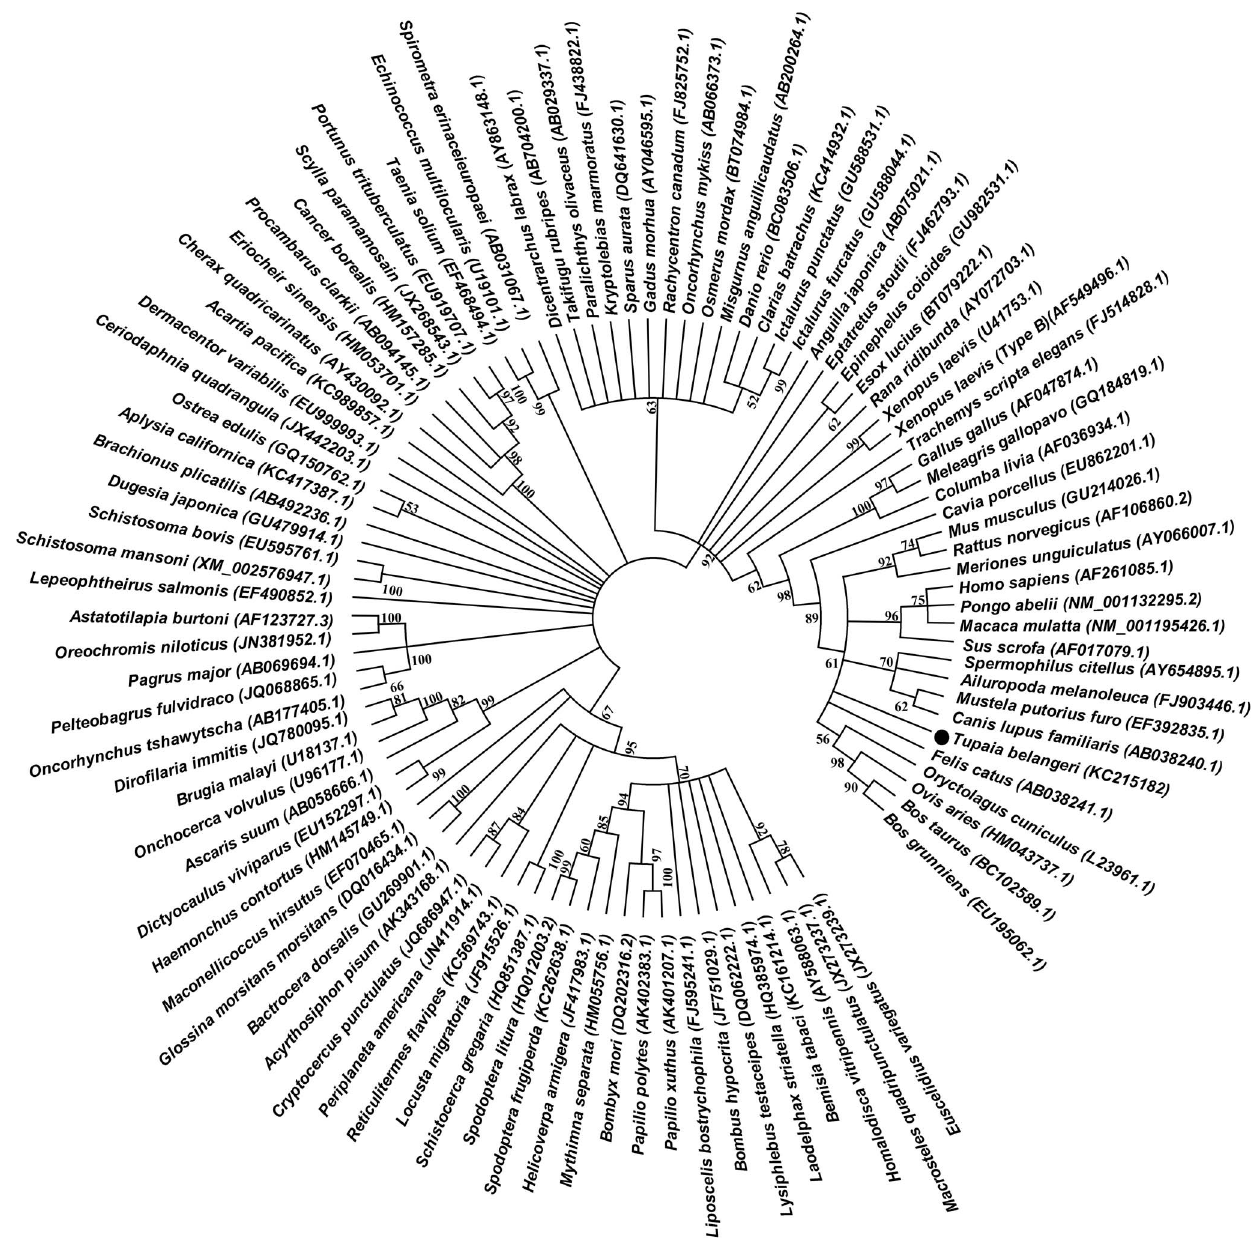
Figure 1. Phylogenetic analysis of GAPDH. The Phylogenetic tree is based on deduced full-length amino acid sequences of GAPDH and constructed with the neighbor-joining method. Only bootstrap values over 50% are shown.